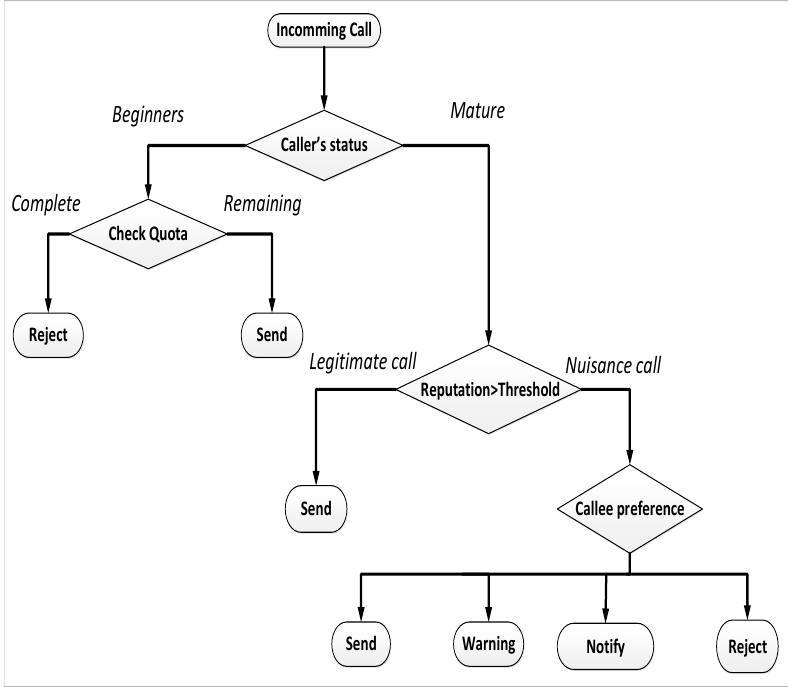
Figure 7. Decision module flow